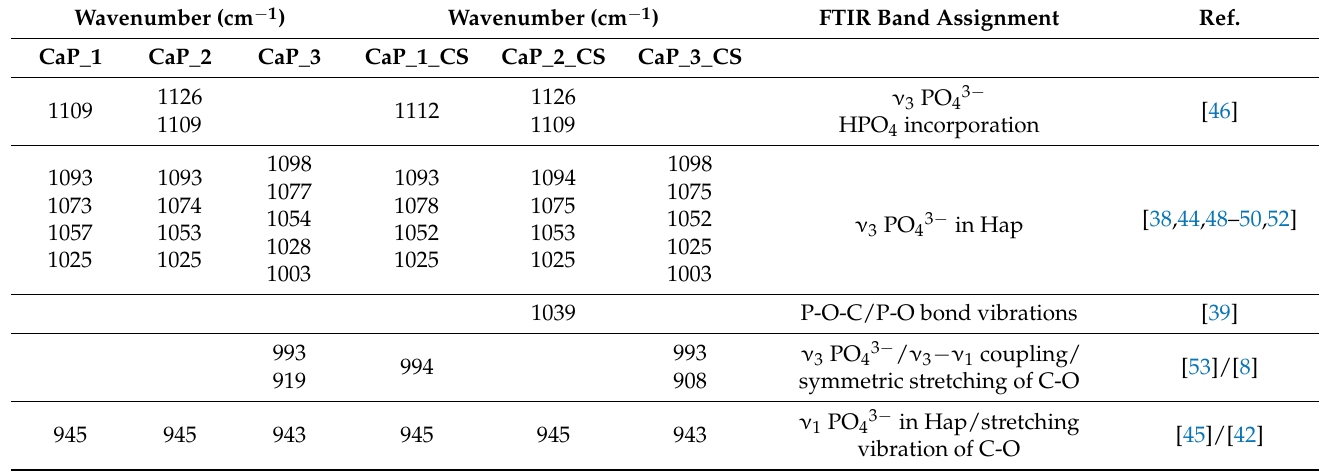
Table 4. The assignment of FTIR absorption bands for the CaP_CS coatings in the wavenumber domains: 4000–2500 cm − 1 and 1800–1200 cm − 1.